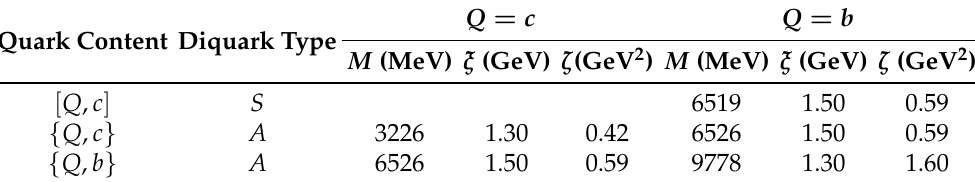
Table 3. Masses M and form factor parameters of doubly heavy QQ (cid:48) diquarks. S and A denote scalar and axial-vector diquarks, antisymmetric [ Q , Q (cid:48) ] and symmetric { Q , Q (cid:48) } in flavour,